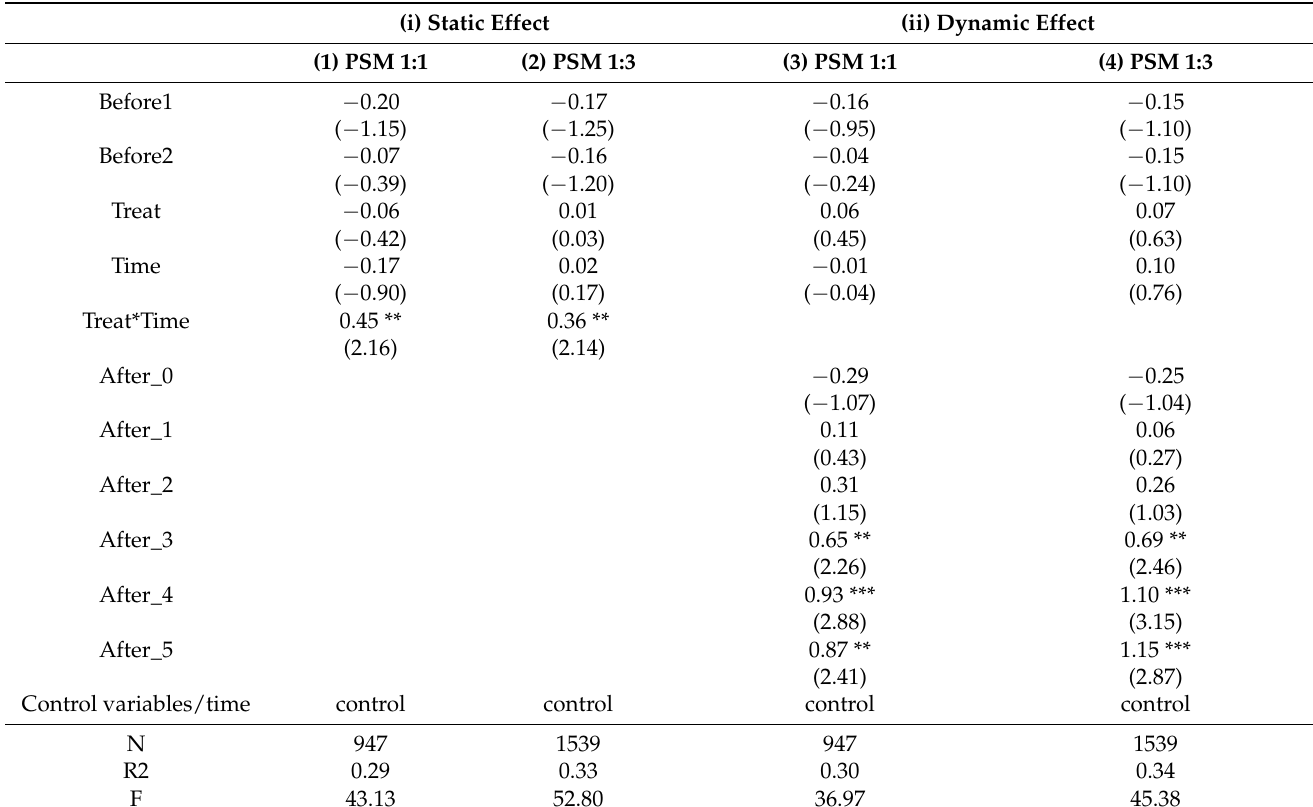
Table 7. Robustness